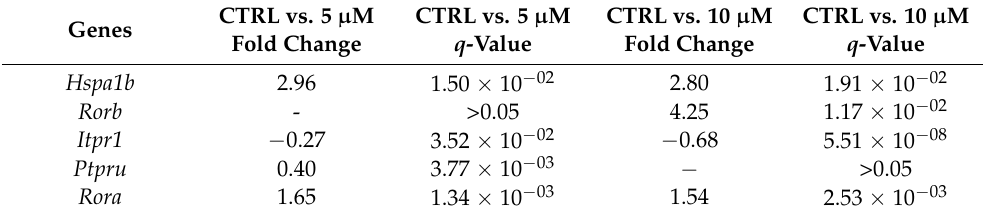
Table 8. DEGs associated with RORs.